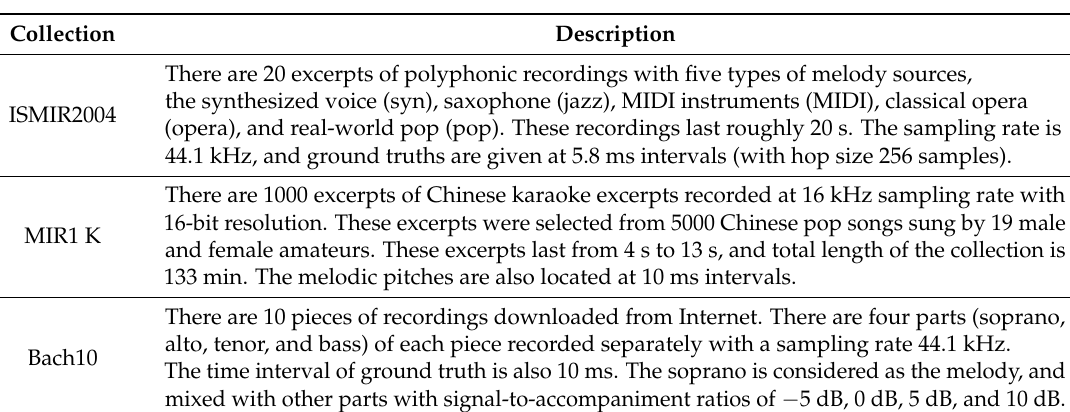
Table 1. Evaluation